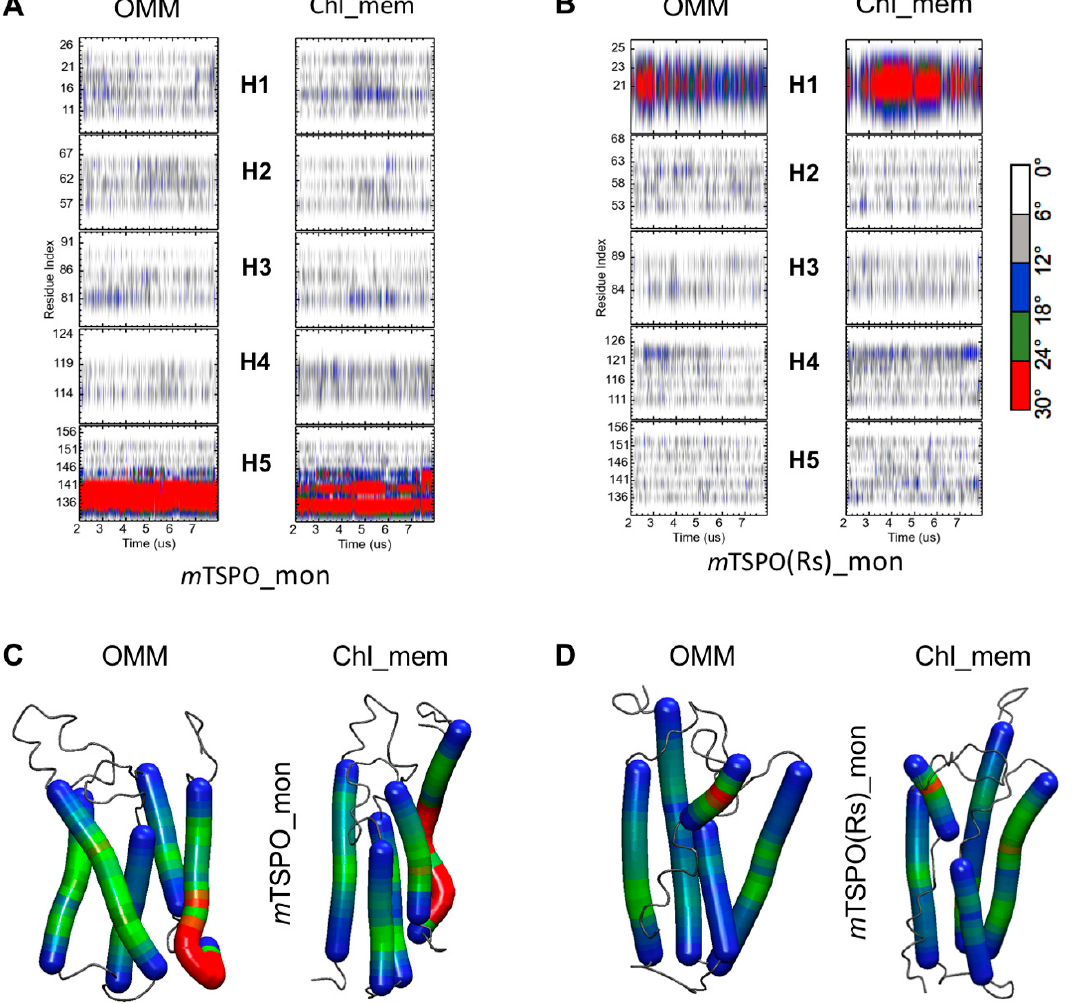
Figure 6. The helix bending of ( A ) m TSPO_mon and ( B ) m TSPO(Rs)_mon embedded in both OMM and chl_mem as a function of the simulation time. Only the last 6 μ s are shown. The corresponding helix “hinge” regions are also shown on m TSPO_mon ( C ) and m TSPO(Rs)_mon ( D ) structures in OMM and chl_mem: the highly bent regions are highlighted in red color, while the least and moderately bent regions are highlighted in blue and green colors, respectively.